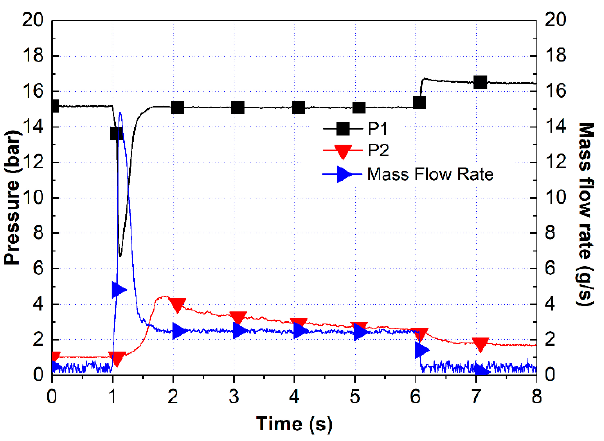
Figure 8. Test result for the Pt/BHA catalyst with preheated catalyst bed at 300